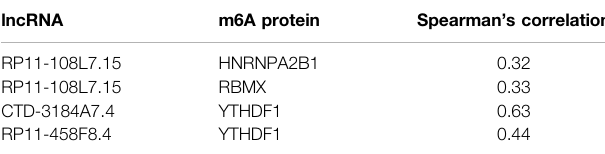
TABLE 1 | The interaction between lncRNAs and m6A proteins by